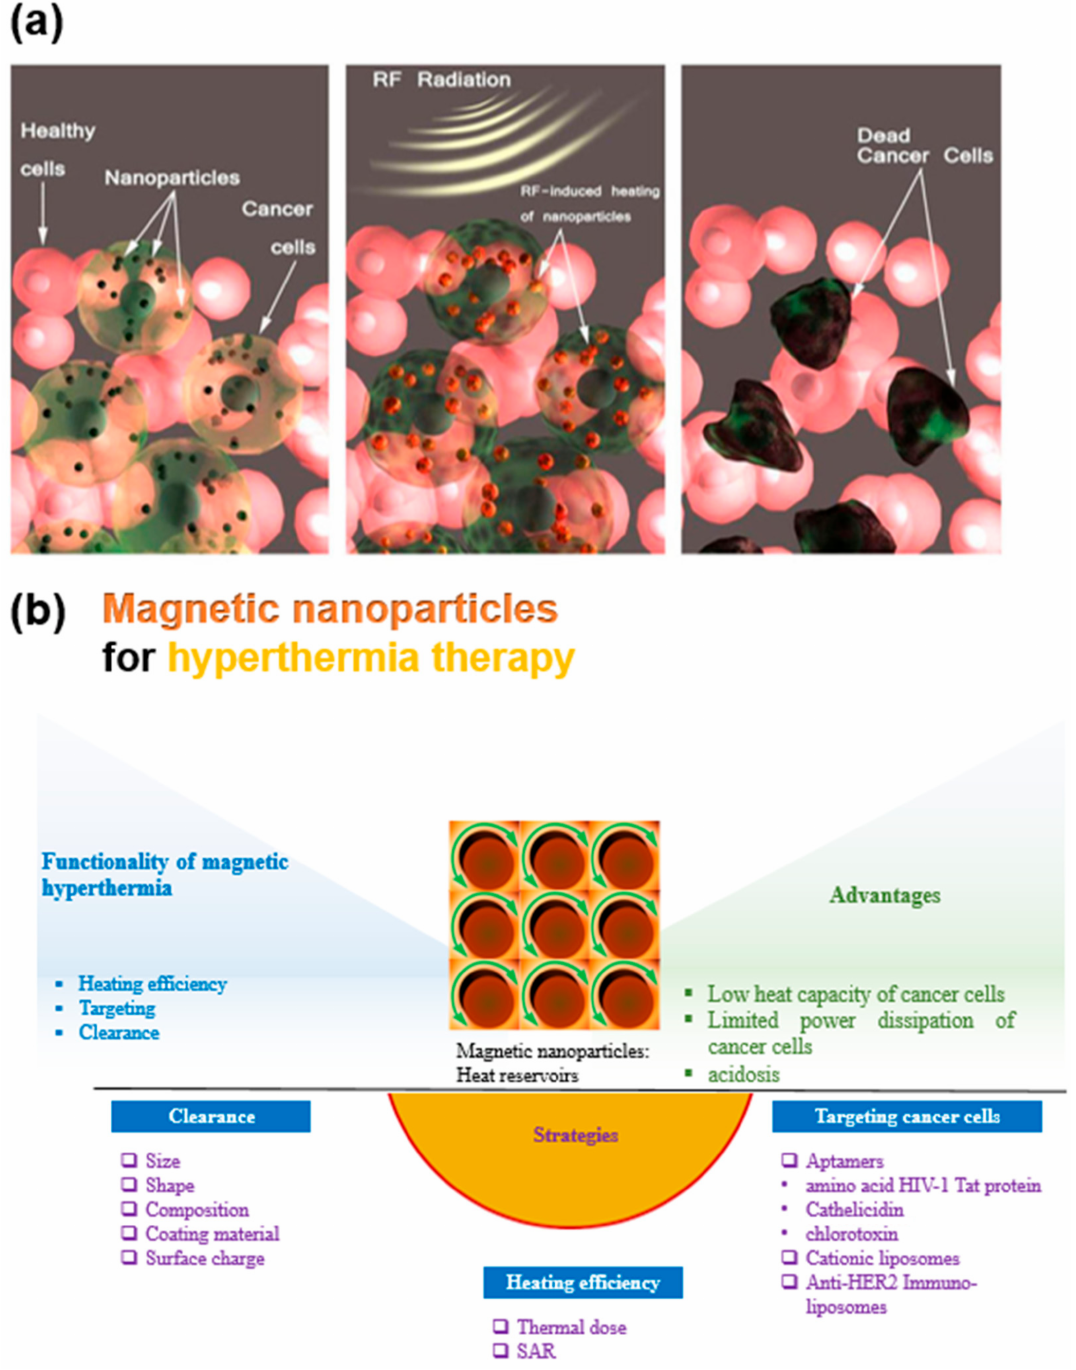
Figure 1. ( a ) Schematic representation of the magnetic hyperthermia treatment procedure. Reprinted with permission from [21]. Copyright 2014 Springer Nature. ( b ) Factors affecting the functionality of magnetic